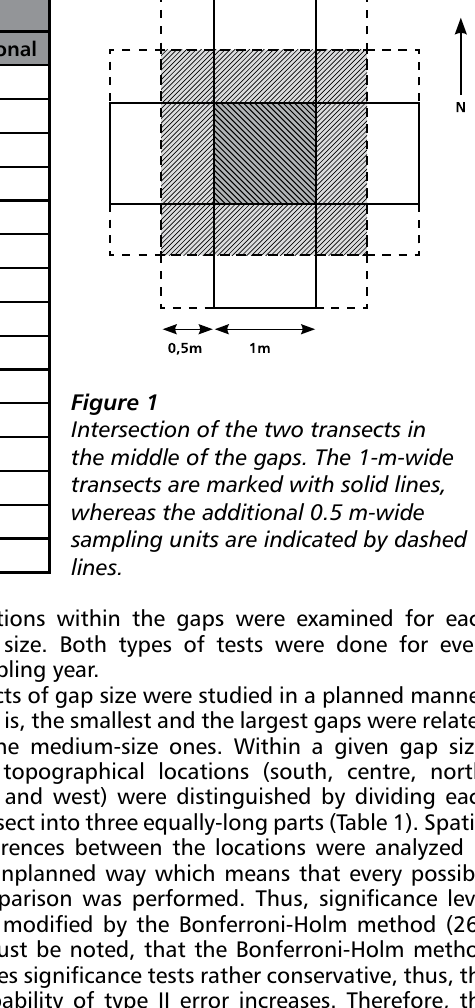
Sampled area (in m²) of various topographical positions within the experimental gaps of different sizes. Method – regeneration technique applied; Location – topographical position inside the gaps; One gap – sampled area within one gap of a given size; Total – total sampled area in all gaps of a given size; transect – sampled area of the 1-m-wide transects (which equals the number of the 1 x 1 m sampling quadrats distributed along the transects); additional – sampled area of the additional 0.5 m-wide sampling units placed at both sides of the 1-m-wide transects; G15, G30, G45 – gaps of 15 m, 30 m and 45 m in diameter, respectively; S, C, N, E, W – south, central, north, east and west parts of the gaps, respectively. Note that